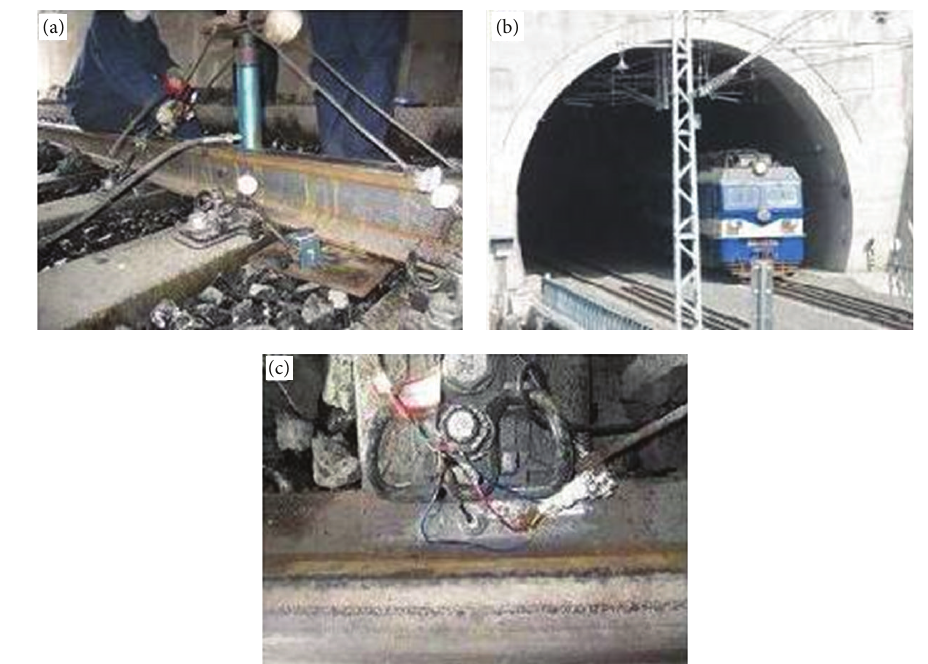
Figure 5: In-situ tests: vertical static track stiffness test (a), the train passing through the transition section (b), and layout of accelerometers on rails (c).